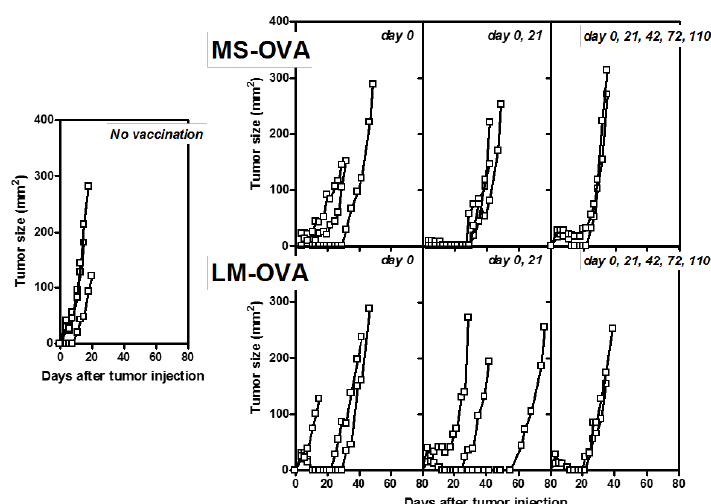
Figure A1. Tumor challenge 323 days following regular prime-boost vaccinations with MS-OVA or LM-OVA. C56BL/6 mice were vaccinated by s.c. injection with 20 µg MS-OVA or 10 4 of LM-OVA in the middle of the dorsal flank at day 0, 21, 42, 72, and 110 as indicated in the legend. Three hundred twenty-three days after the initial vaccination, 10 6 B16-OVA cells were injected s.c. in the lower dorsal flank. Survival was measured over time.